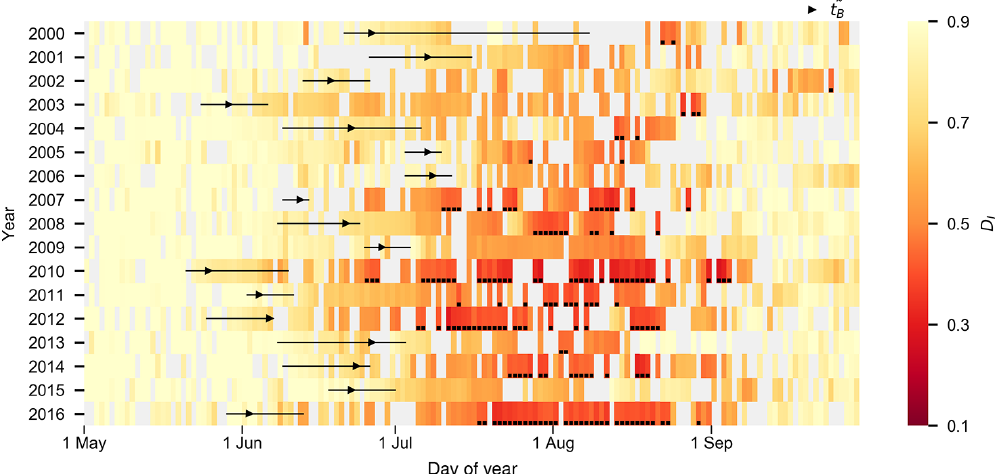
Figure 2. D I in the common area during May to September from 2000 to 2016. Only days on which at least 50% of the common area is cloud-free are shown. Black squares denote days on which the average dark ice intensity, D I , of the cloud-free common area was < 0.45. Black triangles denote the date of snow clearing, e t B . Horizontal black bars denote the interquartile range of the day of year of bare ice